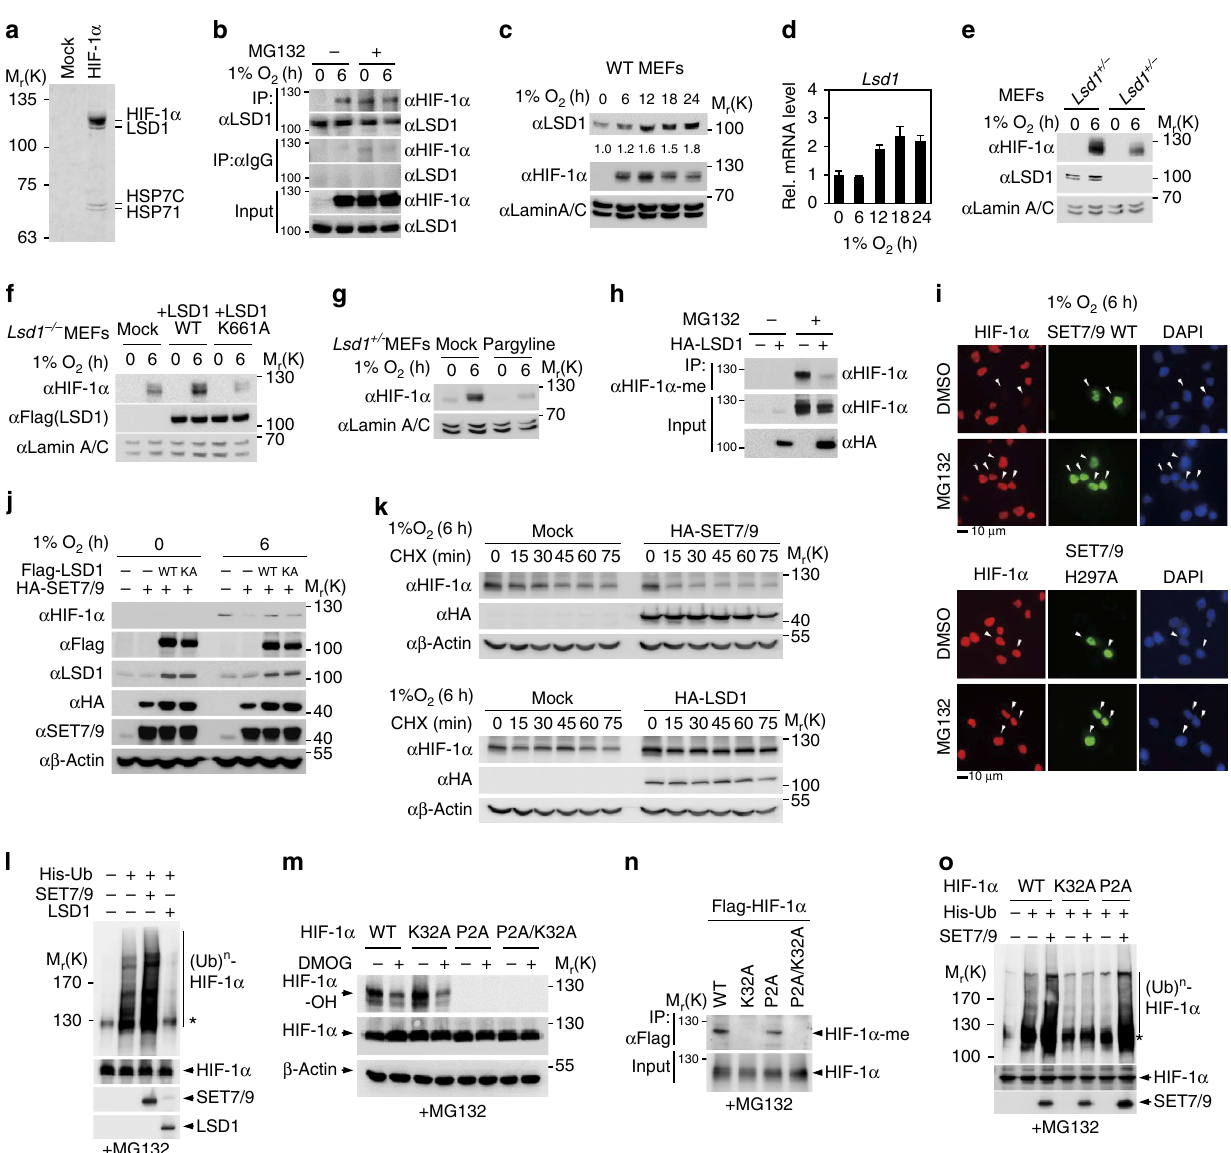
Figure 2 | LSD1-mediated HIF-1 a demethylation increases HIF-1 a protein stability. ( a ) HIF-1 a -interacting proteins were purified from HEK293T cells under hypoxic conditions by Flag-M2 agarose. Bound proteins were resolved by SDS–PAGE and prepared for LC-MS/MS